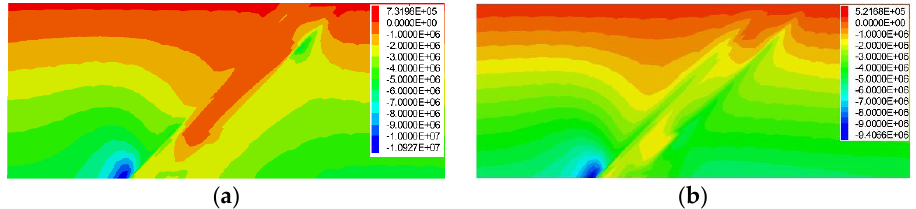
Figure 15. Stress cloud diagram of overburden rock of different backfilling bodies ( a ) Full tailings cemented backfilling and ( b ) Medium and fine tailings paste backfilling.